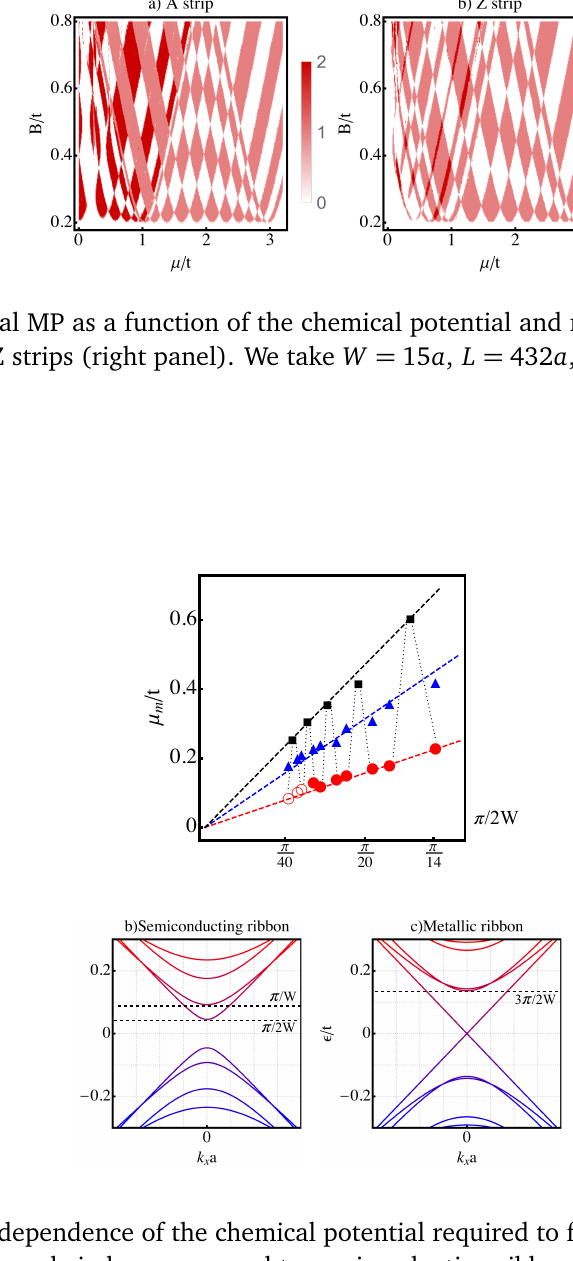
Figure 7: a) The dependence of the chemical potential required to form MBS as a function of ribbon width. The red circles correspond to semiconducting ribbons, while the black squares to metallic ones. The blue triangles correspond to the second lowest value of the required ≈ ∆ . The chemical potential. For all these points we consider the formation of MBS at V Z ≈ ∆ . The dashed red line corre- empty red circles correspond to the formation of MBS at V Z = π/ 2 W , the dashed black sponds to the gap of a semiconducting ribbon E gap-semiconductor = 3 π/ 2 W , line to the minimum of the second band of a metallic ribbon E second-band-metal while the blue dashed line to the minimum of the second band for a semiconducting ribbon = π/ W . b) The band structure for a parent infinite semiconducting E second-band-semiconductor strip of width W . c) The band structure for a parent infinite metallic strip of width W